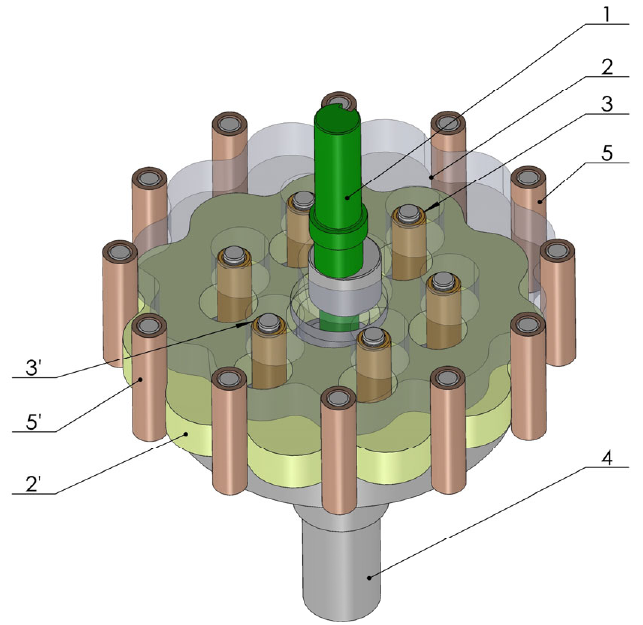
Figure 1. 3D model of a classic single-stage cycloid speed reducer: 1—input shaft; 2 and 2 ′ —cycloid discs; 3 and 3 ′ —output rollers; 4—exiting mechanism, and 5 (5 ′ )—ring gear rollers.